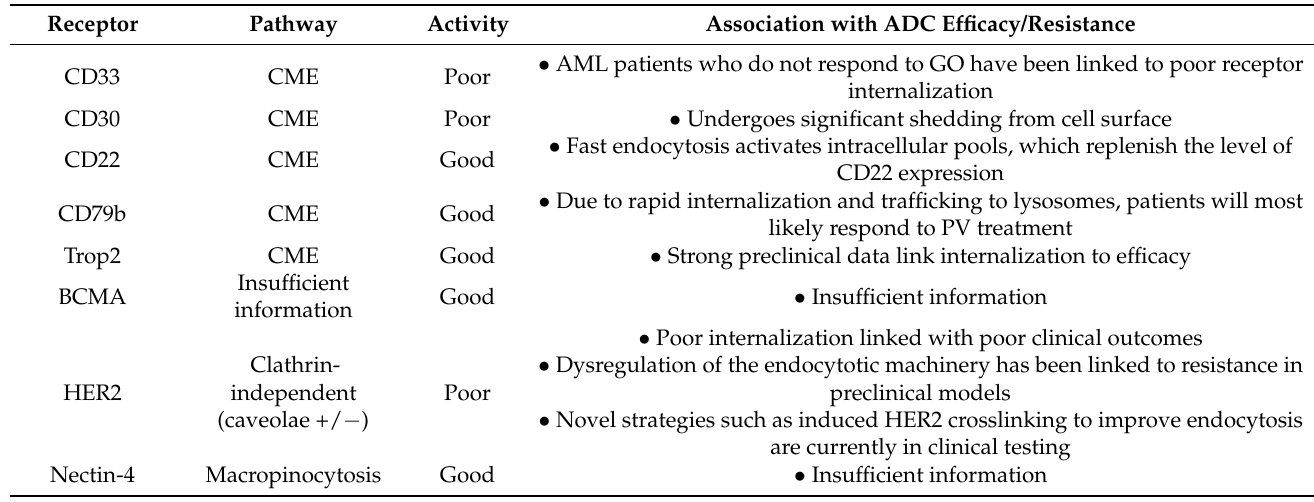
Table 2. Summary of endocytosis activities for the receptors for the currently approved ADCs. Receptor Pathway Activity Association with ADC